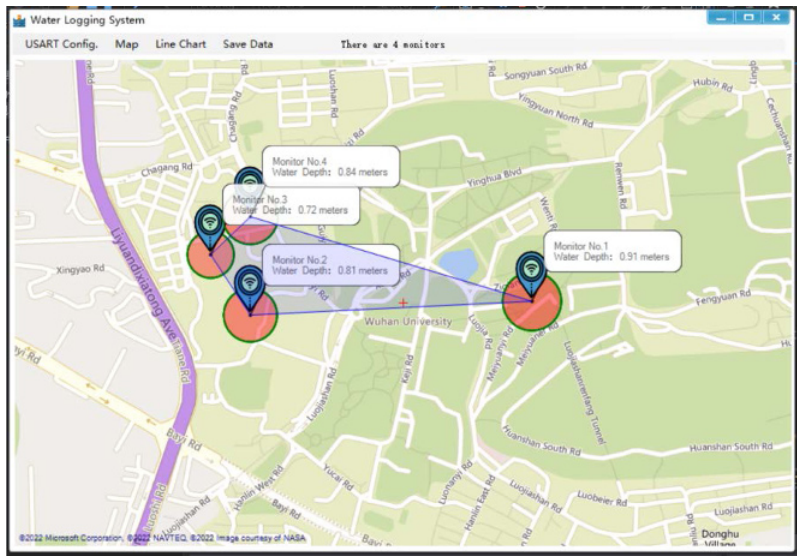
Fig. 2. Main interface of upper computer.